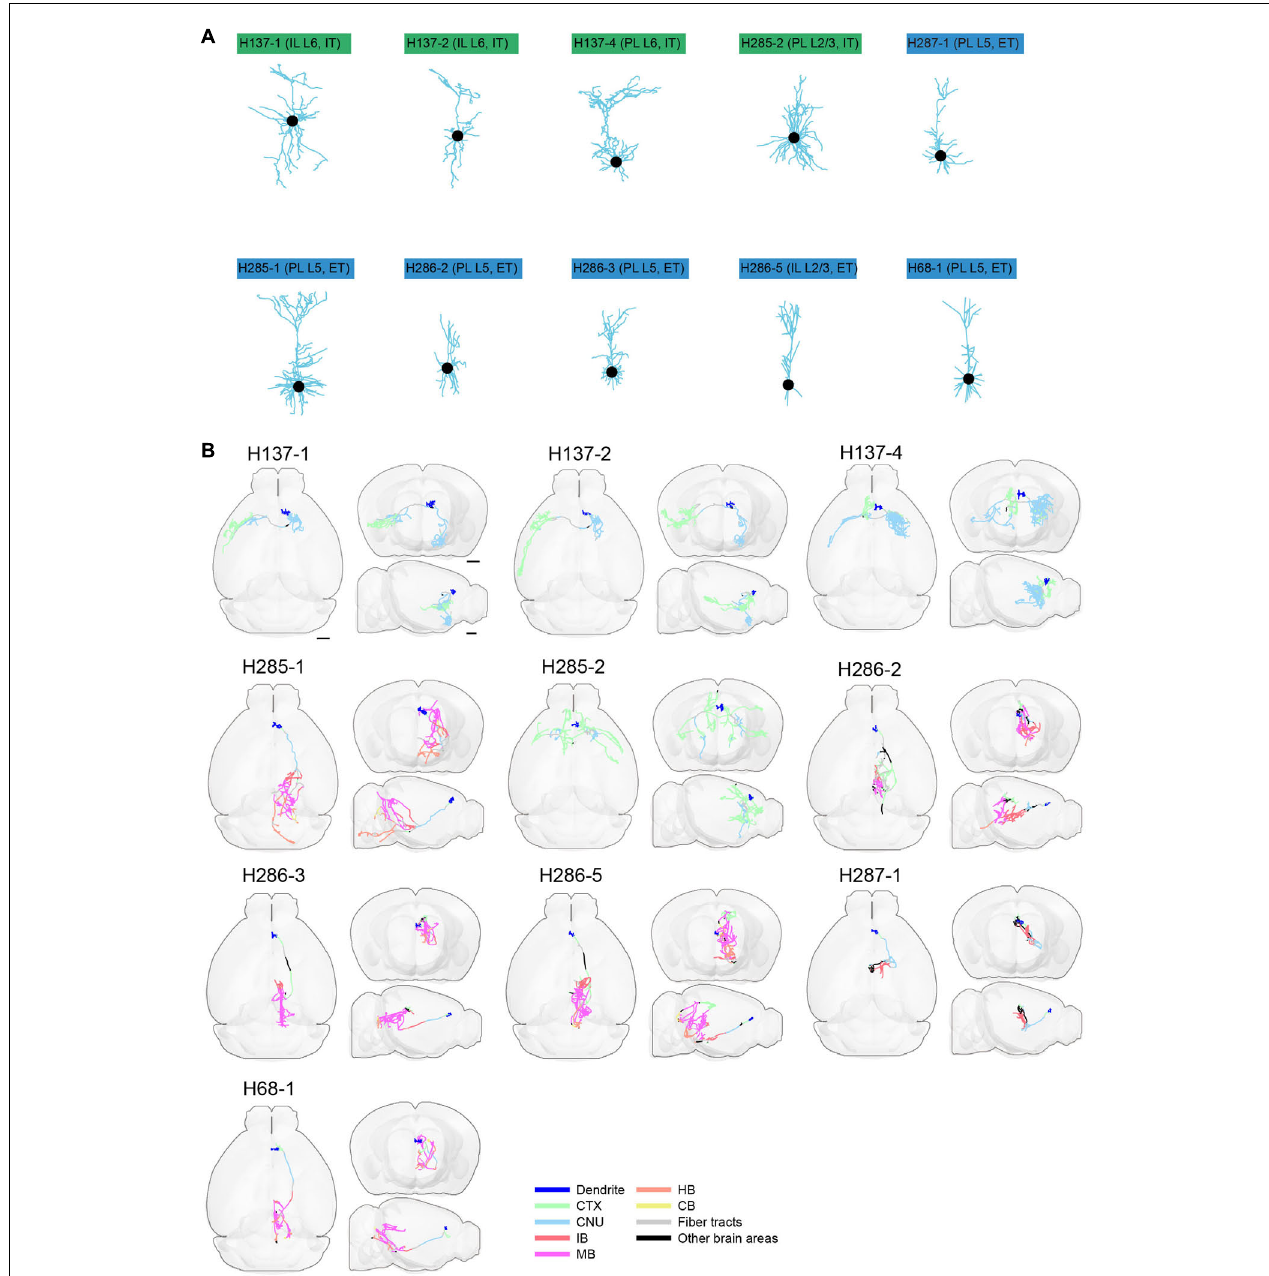
FIGURE 13 | Morphology of reconstructed mPFC neurons. (A) Morphology of dendrites of different types of neurons in mPFC ( n = 10). Dendritic morphology of IT (green) and ET (blue) neurons are shown. (B) Horizontal, coronal, and sagittal views are shown for each neuron in (A) . Dendrites are shown in blue. Axons in each indicated brain areas are color-coded using the same scheme as in CCFv3. CTX, cerebral cortex; CNU, cerebral nuclei; IB, interbrain; MB, midbrain; HB, hindbrain; CB, cerebellum. Scale bar, 1